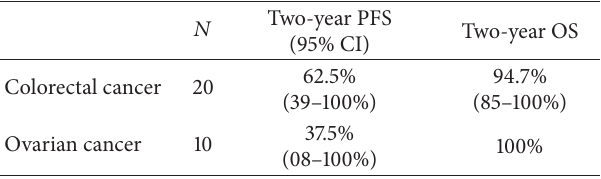
Table 4: Table depicting outcomes (overall survival and progression free survival) in major